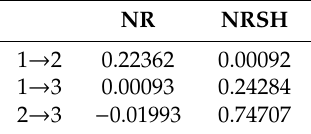
Table 3. Calculated net transferred electrons between fragments of NR and NRSH